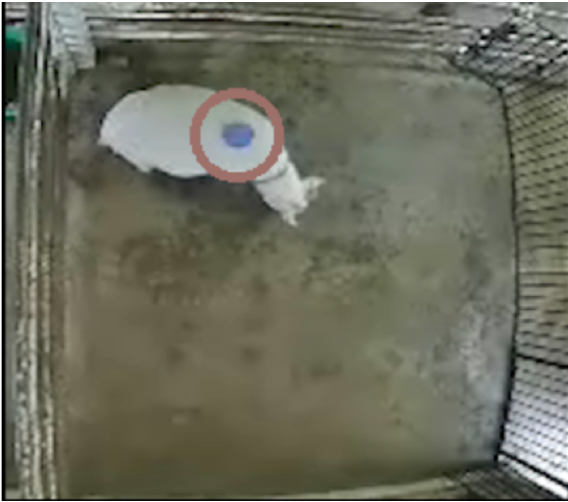
Figure 2. Image from the video recording data. One side of the observation pen was adjacent to the male paddock. A marker was attached to the back of the female goat to track goat